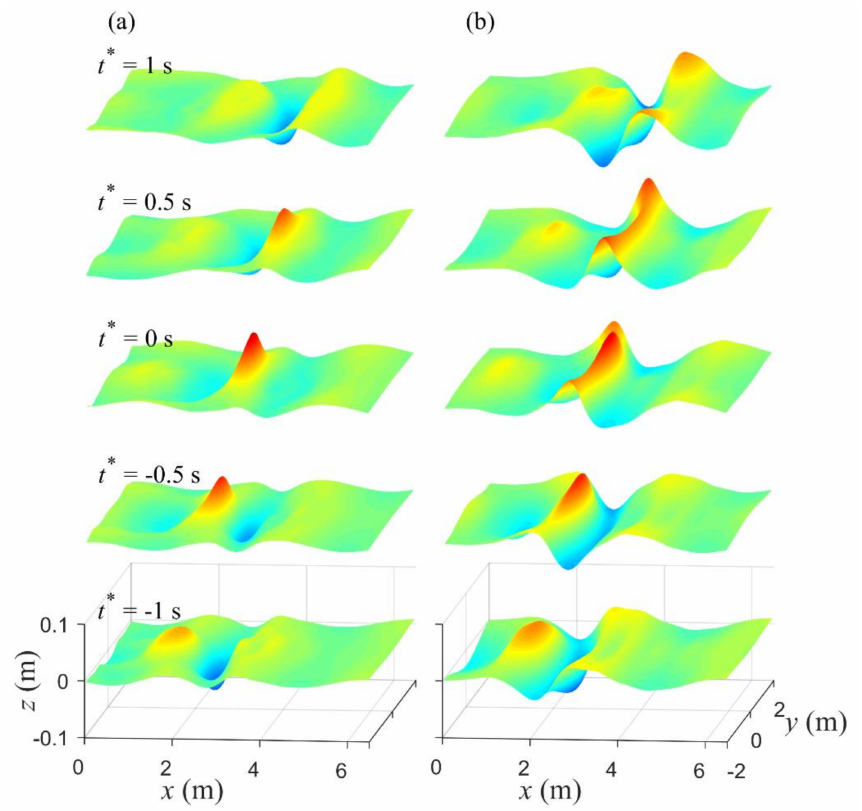
Figure 18. Perspective views of the 3D spatially ( a ) focusing and ( b ) di ff racting waves modeled with the FNHS